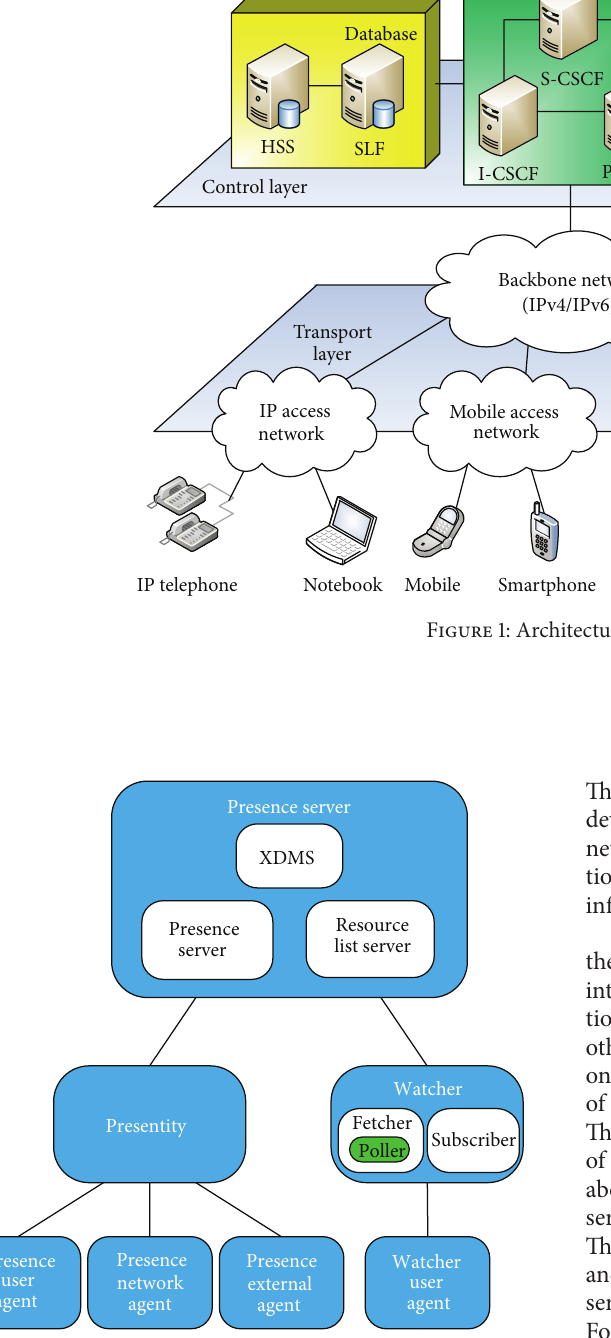
Figure 2: Presence